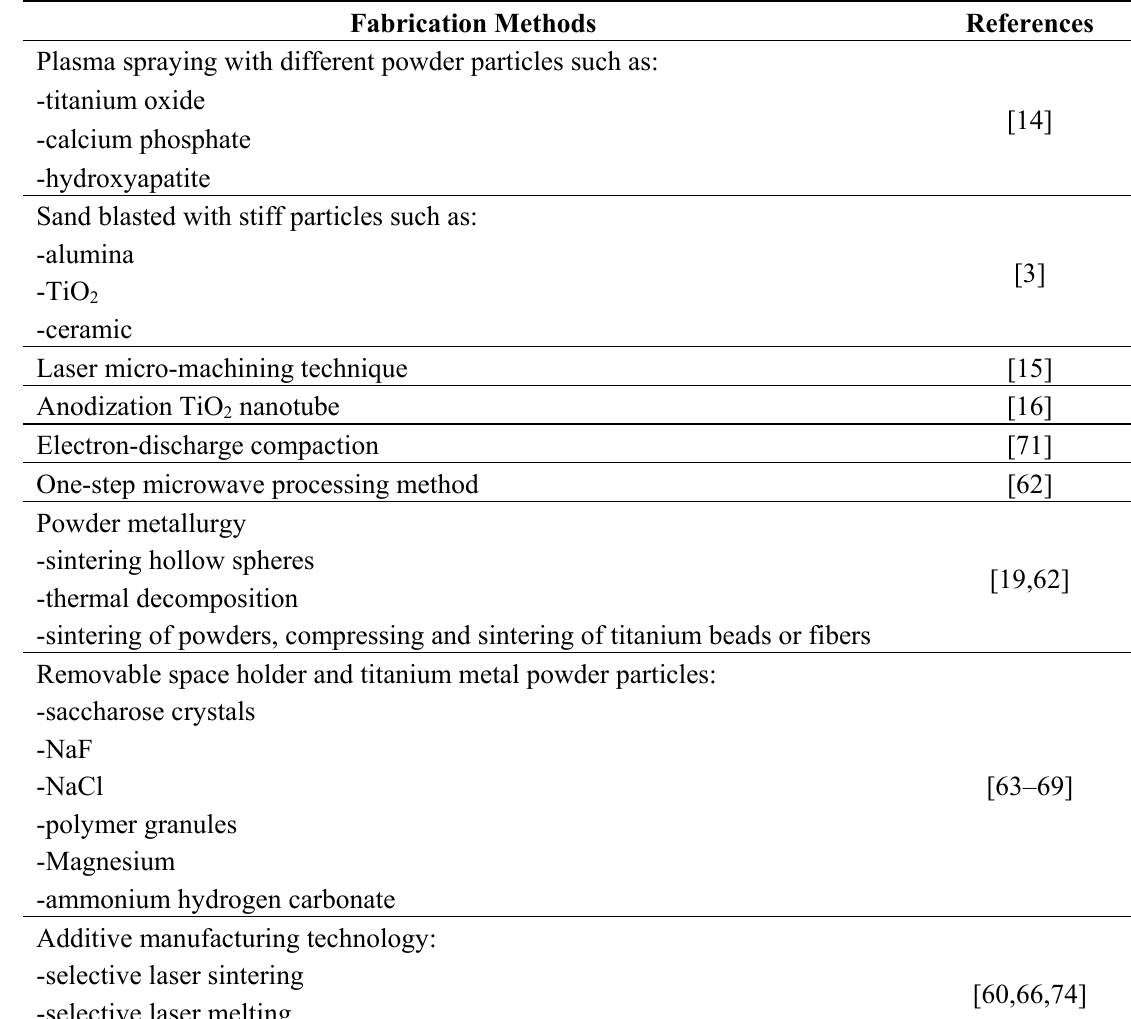
Table 1. Comparison table of the main fabrication methods used for creating rough and porous implants with potential dental and/or orthopedic